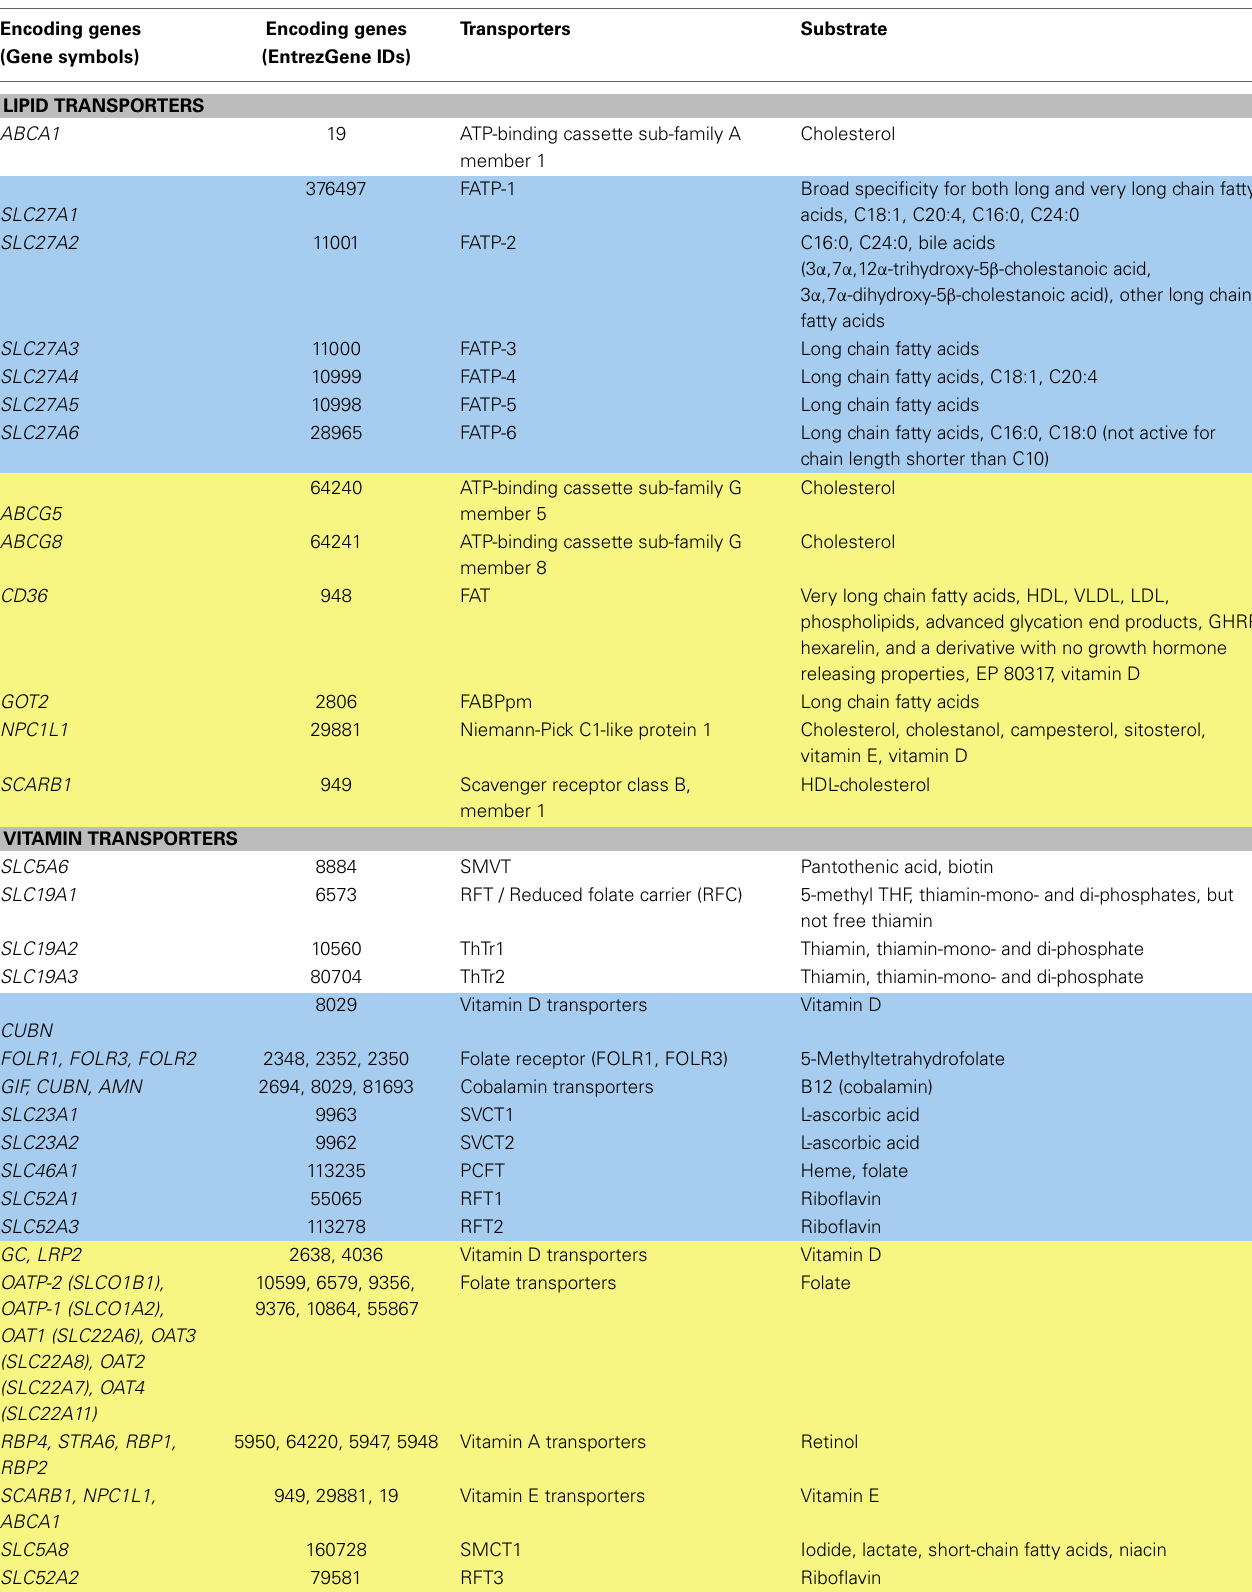
Table 3 | Lipid and vitamin transporters.